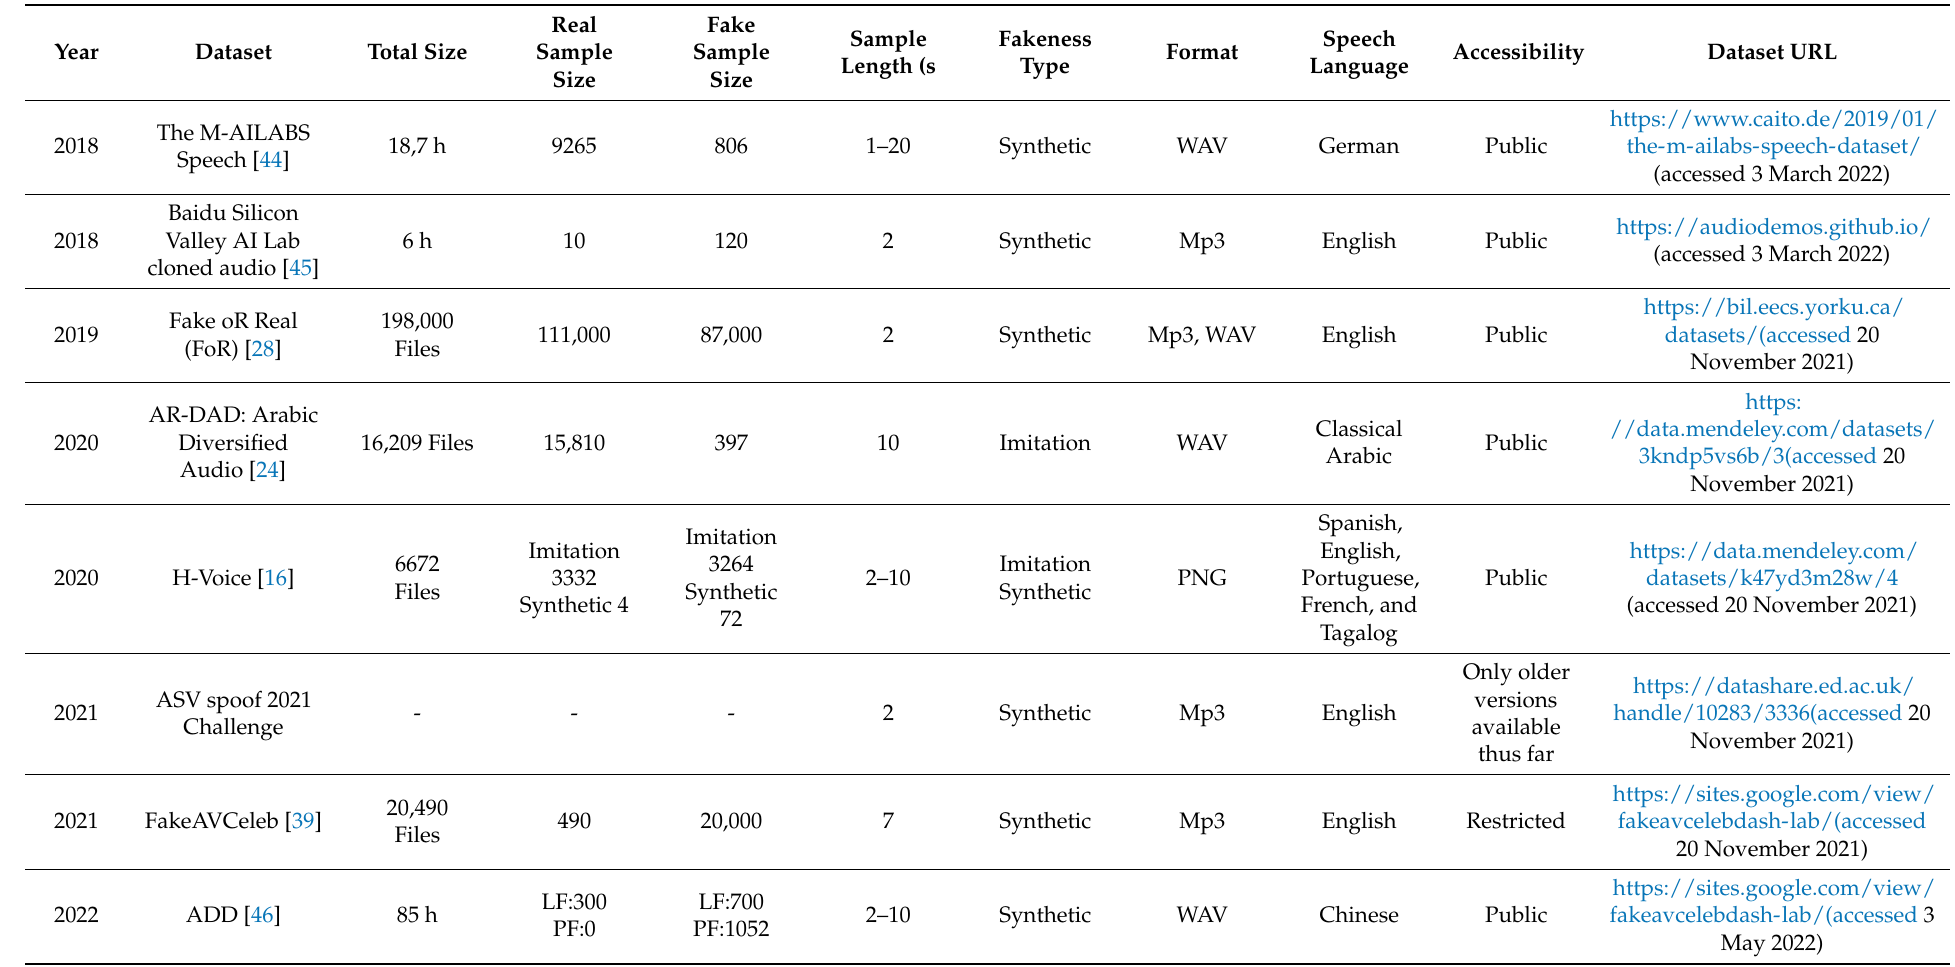
Table 2. Summary of AD